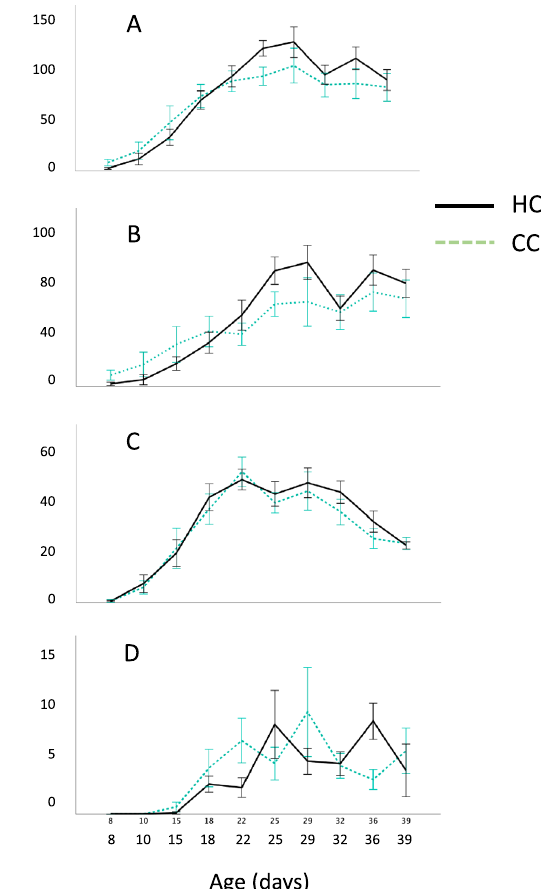
Figure 2. Mean number of observations (± standard error) per group per 30 min of ( A ) total play, ( B ) object play, ( C ) locomotor play, and ( D ) social play at different ages in White Leghorn chicks hatched in a commercial hatchery (HC) or under calm conditions (CC). Note that the scales differ between the